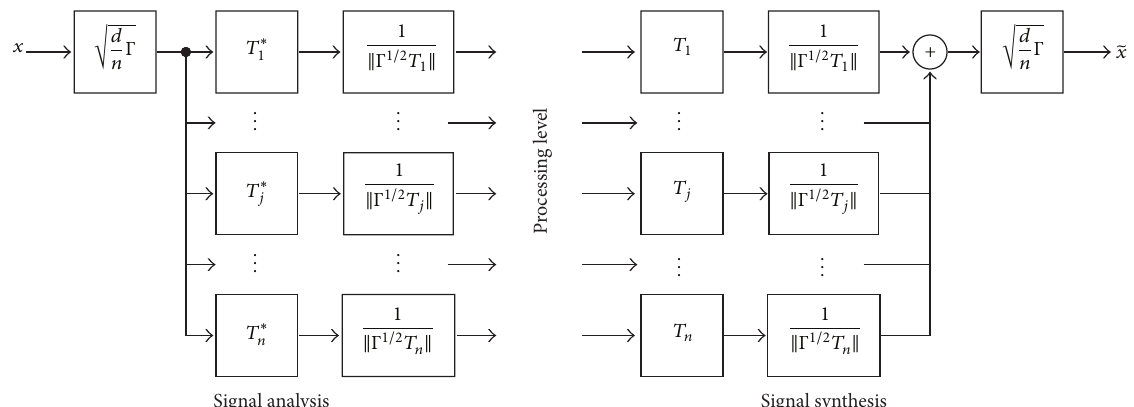
Figure 1: Analysis and synthesis scheme, in which fast matrix vector multiplication of 𝑇 ∗ 𝑗 and 𝑇 𝑗 can still be used after and before pre- and postmultiplication by Γ 1 / 2 ,